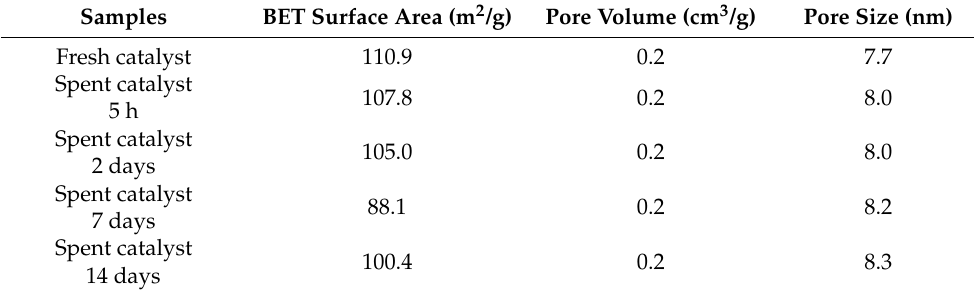
Table 2. Textural properties of catalyst samples.